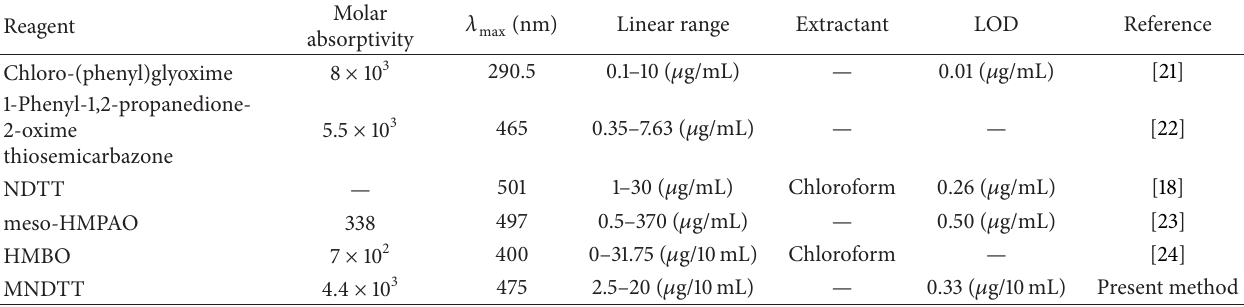
Table 5: Comparison of reagents for the spectrophotometric determination of copper